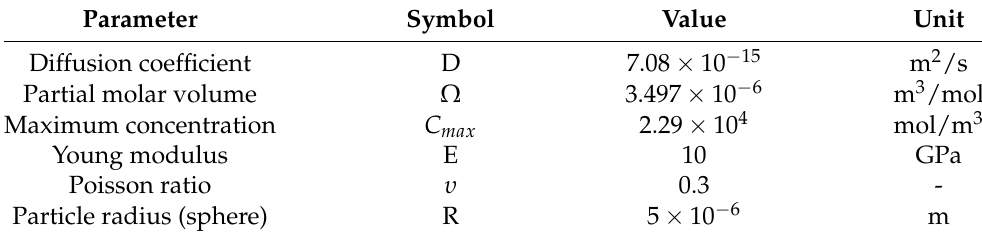
Table 2. Chemical and mechanical properties of Li x Mn 2 O 4 (LMO)